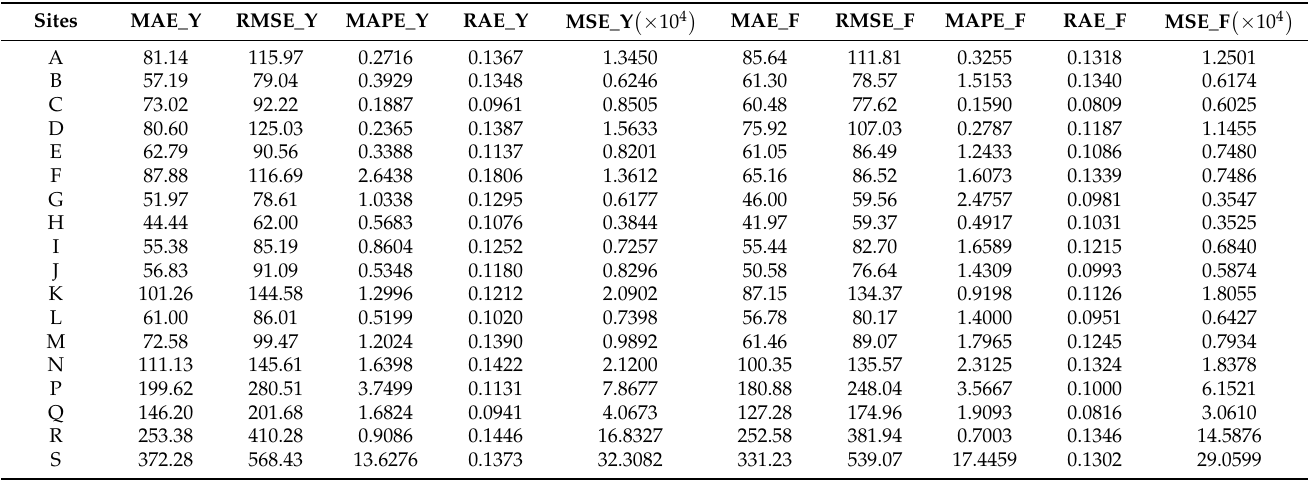
Table 6. Error analysis for the estimated normal distribution (Y) and the estimated fitness curve (F), where the first five columns describe the error in the PDF and the last five columns describe the errors in the fitness curve for the 6 GHz horizontal